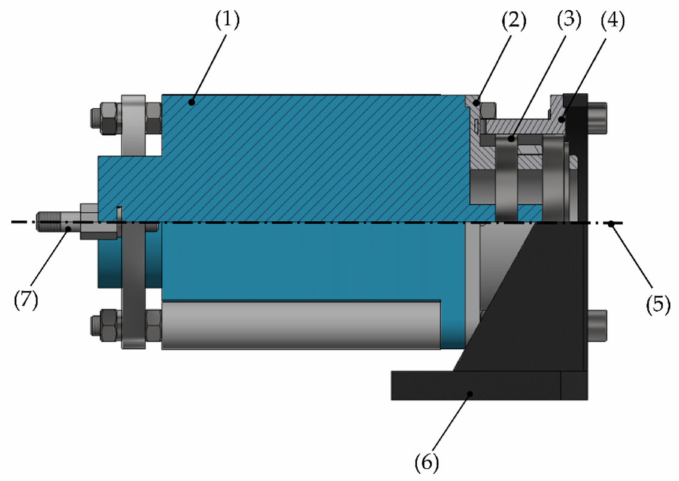
Figure 8. Swing arm motor mount: (1) motor body; (2) internal coupling; (3) bearings; (4) external coupling; (5) motor axis; (6) screws; (7) load cell support.